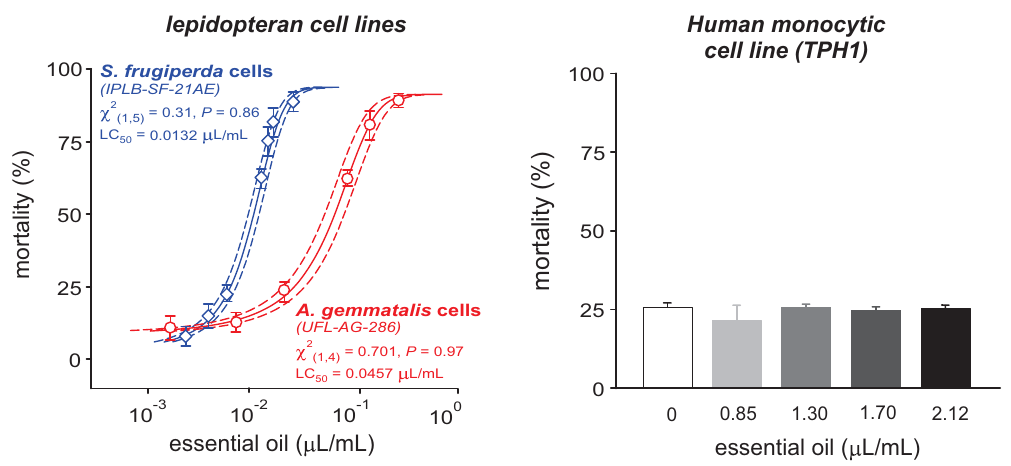
Figure 4. Toxicity of the essential oil of Siparuna guianensis to lepidopteran cells from Spodoptera frugiperda (IPLB-SF-21AE) and Anticarsia gemmatalis (UFL-AG-286) and to Human monocytic cell line